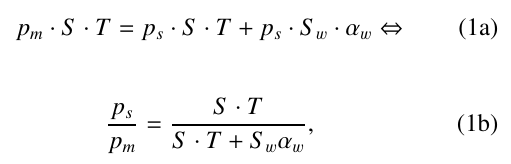
Figure 1. Conversion of collimated beam to stray radiation.